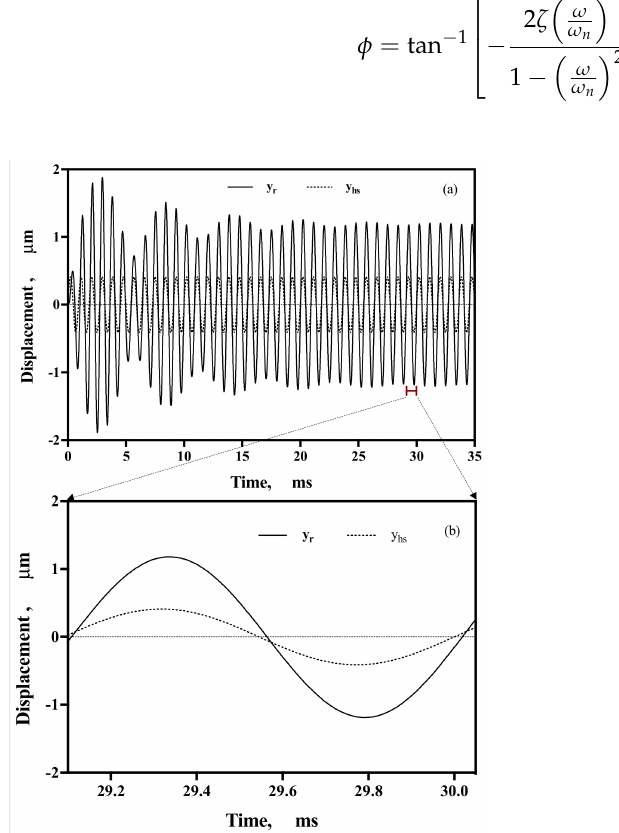
Figure 10. ( a ) Displacement y rA (continuous line) for a reference input signal y hs (dotted line) at 1100 Hz and 0.5 g of acceleration; ( b ) phase shift of 7.92 degrees detected in the last cycle from ( a